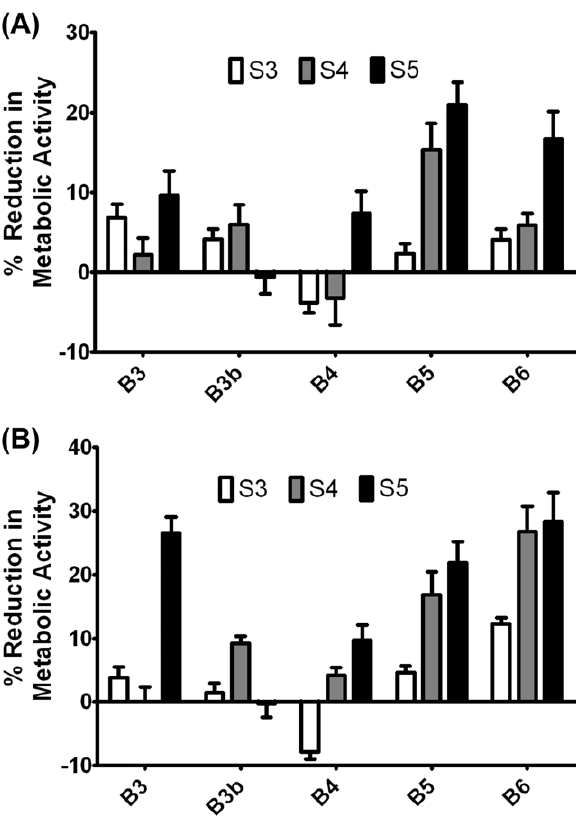
Figure 5. Comparison of base polymer structure with reduction in metabolic activity. Each bar represents the average toxicity associated with the end-modified polymers that contained the base polymer shown (n=11; error bar=SEM). Base diacrylate and side chain amino-alcohols are shown from least hydrophobic to most hydrophobic from left to right. (A) Reduction in metabolic activity of 30 w/w formulations averaged over 10 end-modified amines containing the base polymer shown. (B) Reduction in metabolic activity of 60 w/w formulations averaged over 10 end-modified amines containing the base polymer shown. For statistical analysis, see Table 1.